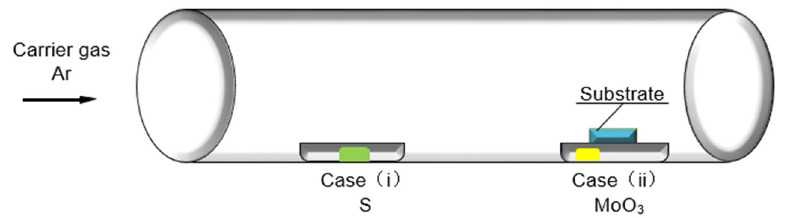
Figure 2. The schematic of experiment setup for 2D MoS 2 chemical vapor deposition (CVD) upon NPAS.